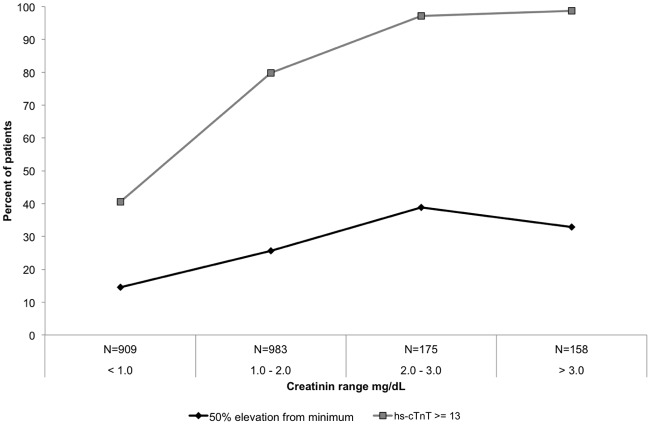
High sensitivity troponin levels and dynamics by creatinine levels.The percent of admissions having maximal hs-cTnT levels > 99th percentile as well as those with hs-cTnT change of 50% or more correlate with patient creatinine levels (p for trend < 0.0001 for both).